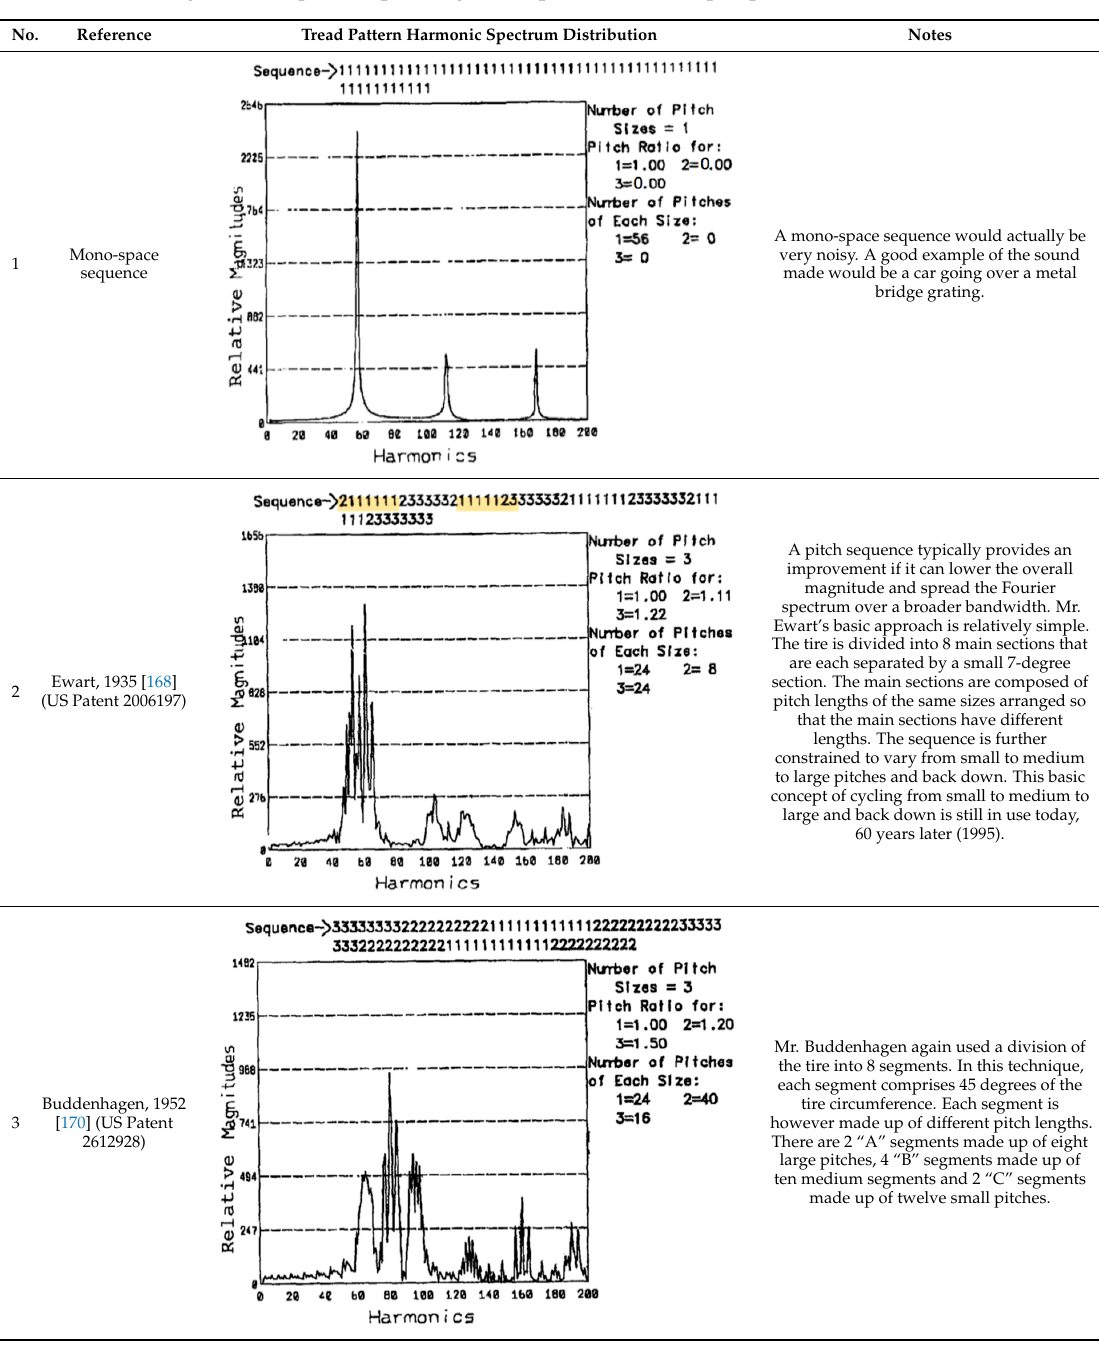
Table 10. Progression of pitch sequencing techniques in historical perspective (Williams, 1995 [165]).